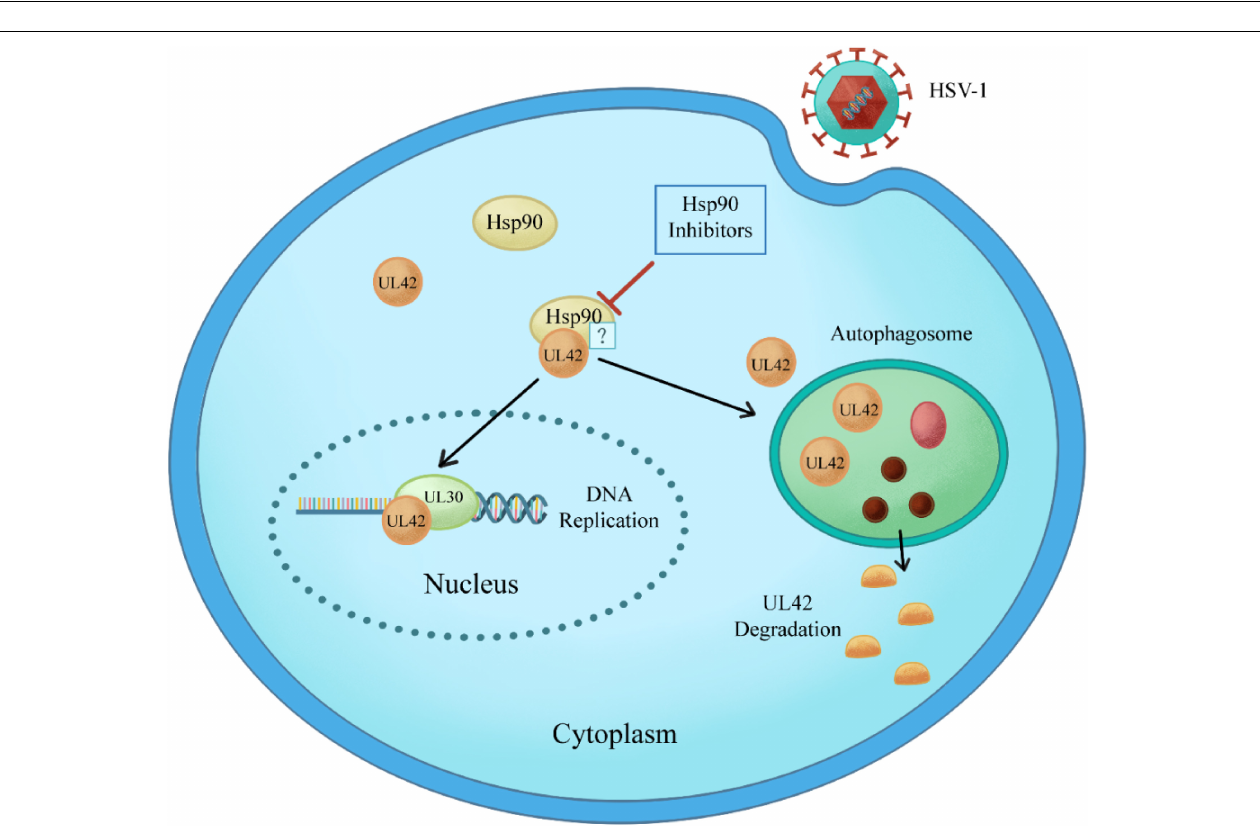
FIGURE 5 | Hsp90 inhibitors restrained ACV-resistant strains (HSV-1/153 and Blue) proliferation. (A) HFF cells were infected with HSV-1/Blue (MOI = 1) and treated with Hsp90 inhibitors at 4 hpi, and at 12 hpi, cell lysates were subjected to Vero cells 96 wells-plate to assess viral titer. (B) HFF cells were infected with HSV-1/153 (MOI = 1) and treated with Hsp90 inhibitors at 4 hpi, and at 12 hpi, cell lysates were subjected to Vero cells 96 wells-plate to assess viral titer. Dilution 1:17-AAG 3.13 µ M, AT-533 2.5 µ M, dilution 2:17-AAG 6.25 µ M, AT-533 5.0 µ M, dilution 3:17-AAG 12.5 µ M, AT-533 10.0 µ M. Data are shown as means ± SEM. The statistical comparisons above are two-tailed, unpaired Student’s t -test with asterisks indicating significance (*** P < 0.005).